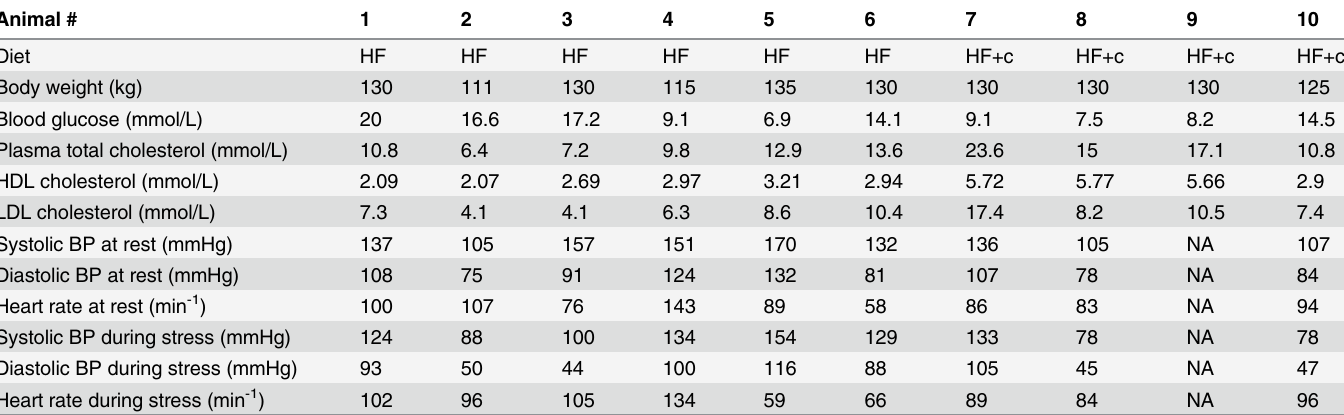
Table 1. Characteristics of pigs with induced diabetes and atherosclerosis at the end of